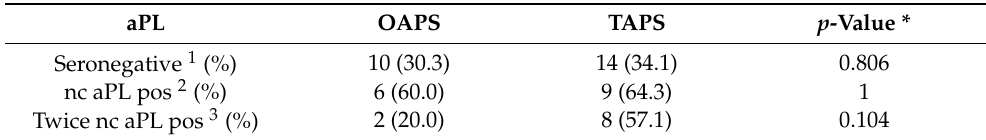
Table 4. Percentage of currently seronegative patients in obstetric antiphospholipid syndrome (OAPS) and thrombotic antiphospholipid syndrome (TAPS) who tested positive for the non-criteria antiphospholipid antibody (nc aPL).